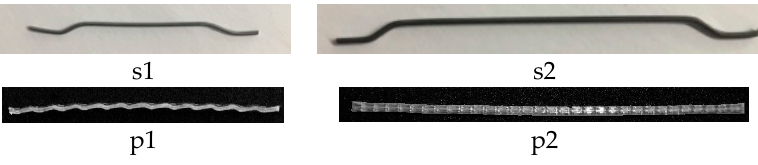
Figure 1. Steel fibers (s1, s2) and macro-synthetic fibers (p1, p2) used in this study. Table 2. Characteristics of steel and macro-synthetic fibers used in this study.